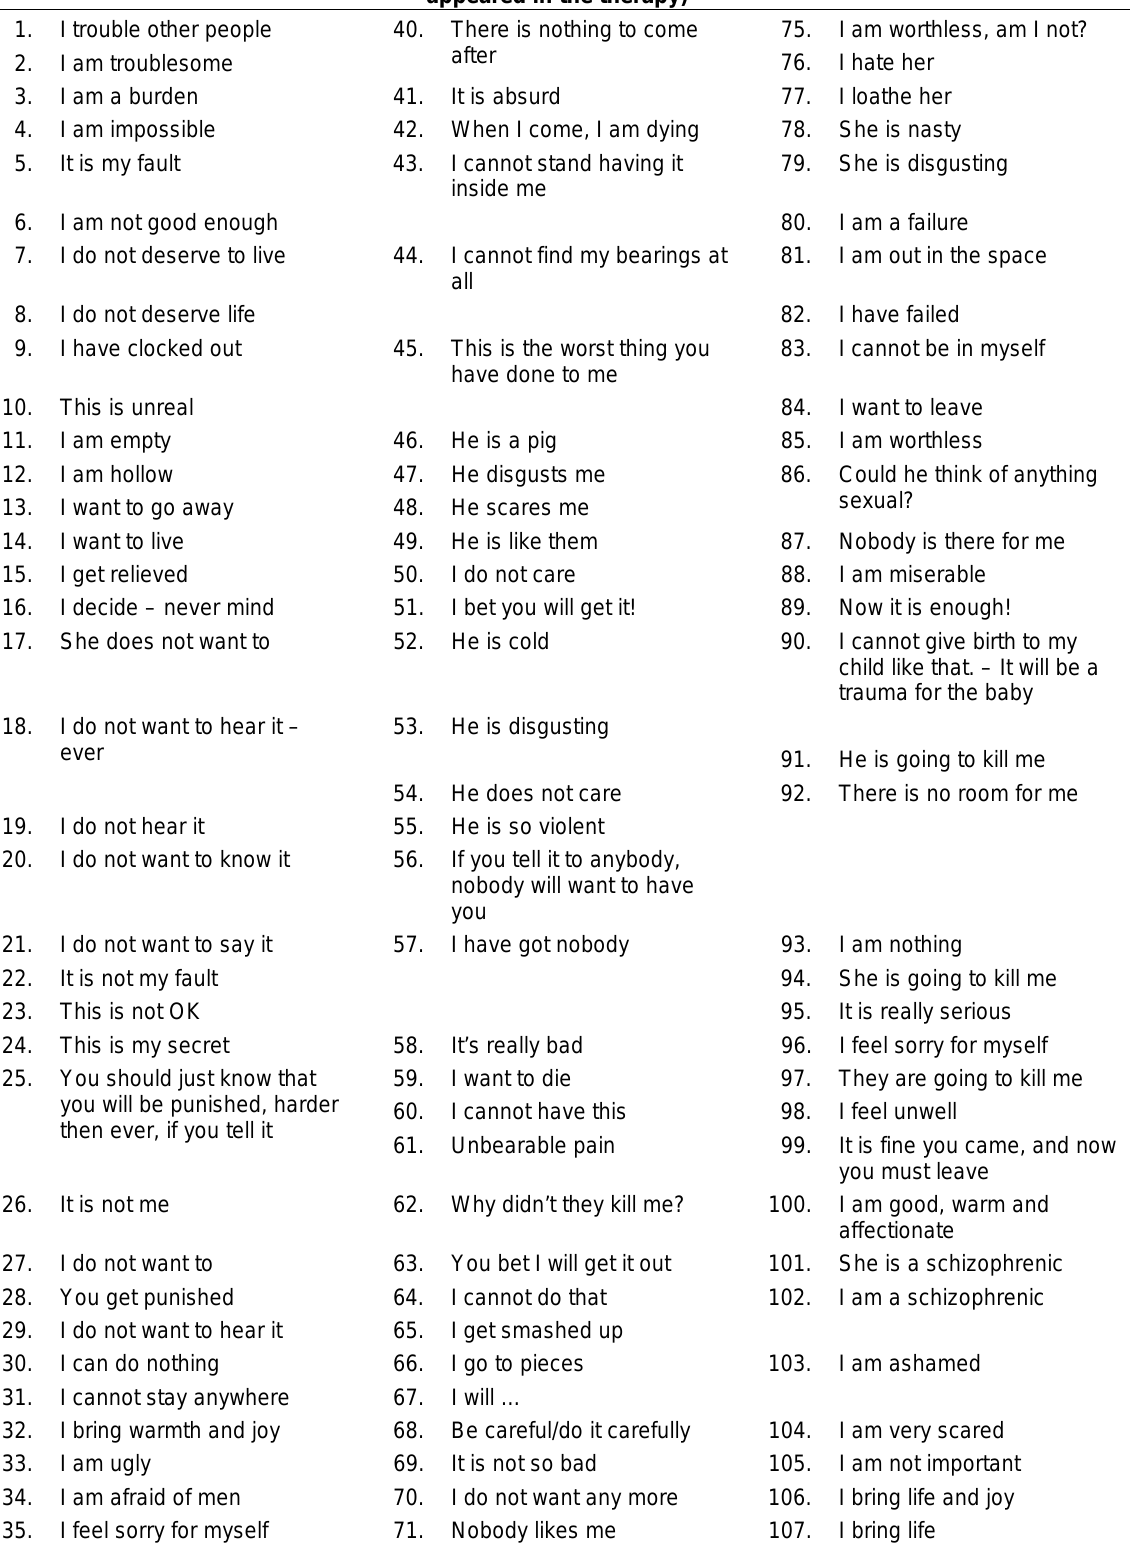
TABLE 2. The Most Importance Sentences Anna Let Go of in Her Holistic Existential Therapy (as